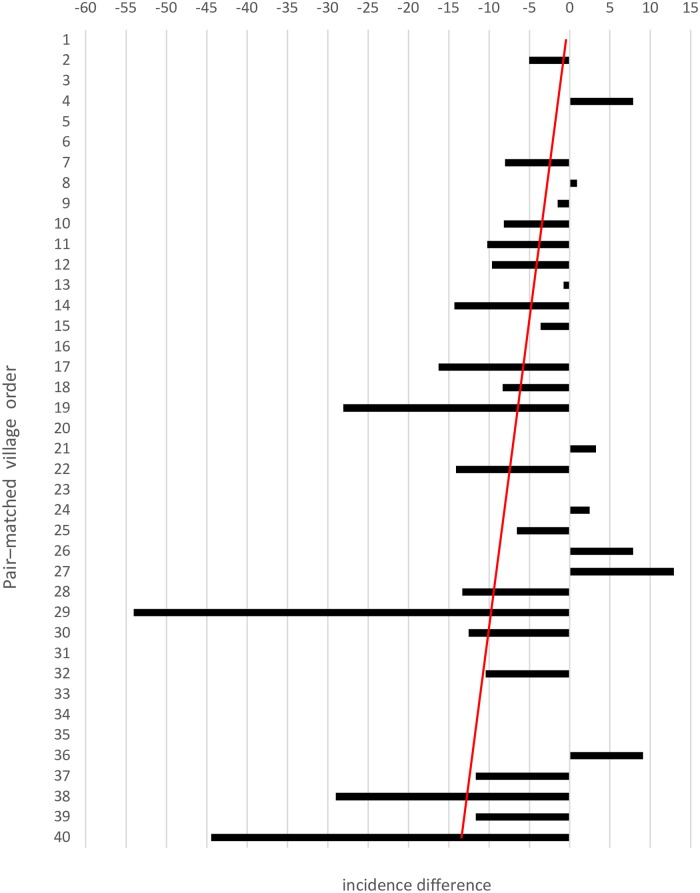
The absolute differences in the post–intervention period VL case incidence per 1000 between the pair–matched collar and control villages.Villages were pair–matched based on their pre–intervention incidence as described in the Methods, and ordered from low to high (Y axis: numbers 1–40). Dashed line: least squares linear fit from regression of the post–intervention incidence difference against the pre–intervention incidence.